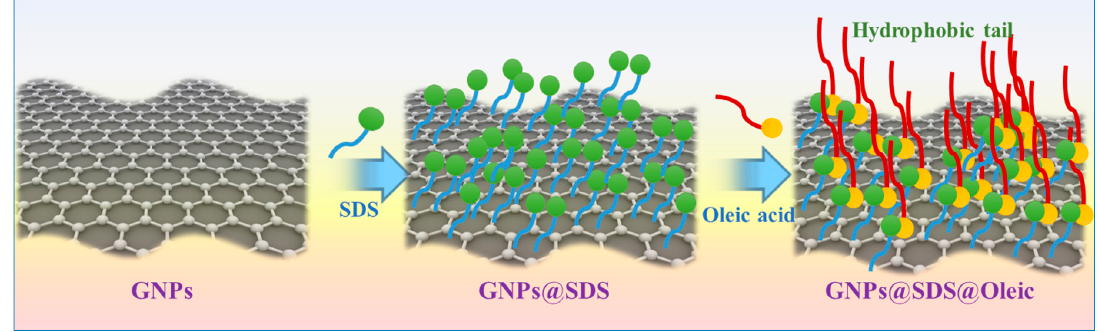
Figure 1. Modification procedure of graphene nanoplatelets with surfactant and organic compound.